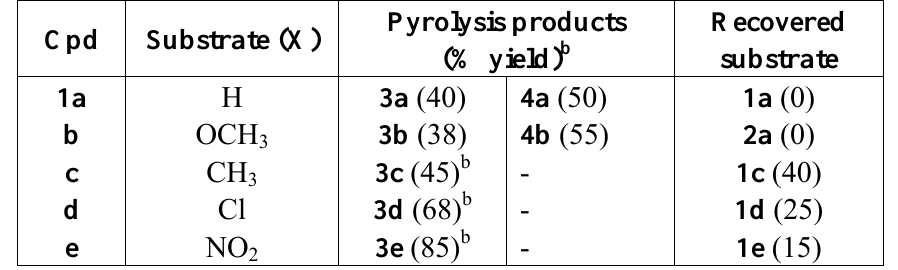
Table 1. Pyrolysis products of 1a-e at 500 °C, 10 -2 Torr and% yield a from